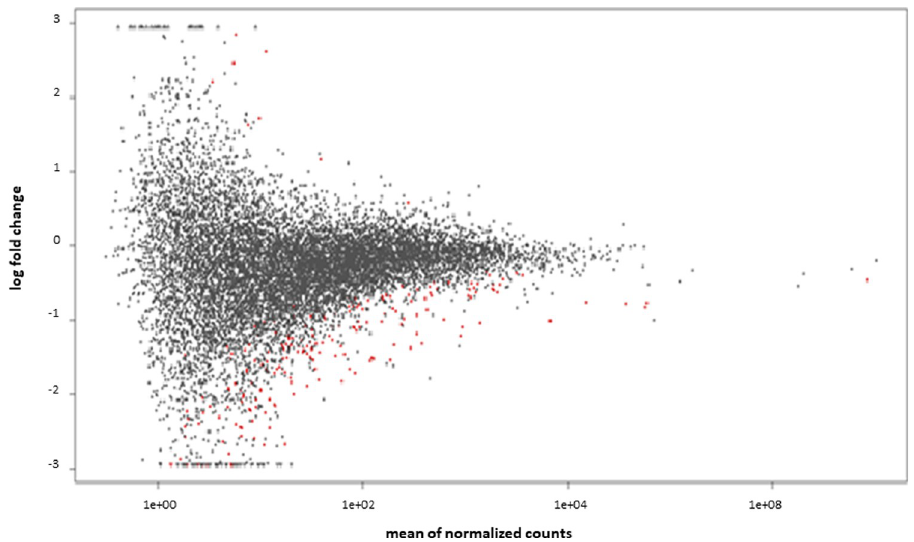
Fig 3. Scatter plot (DESeq2 plotMA) for sperm differential abundance genes between control (October) and heat stress (July) climatic conditions. Red dots show the significant differential abundance genes for an adjusted p-value <